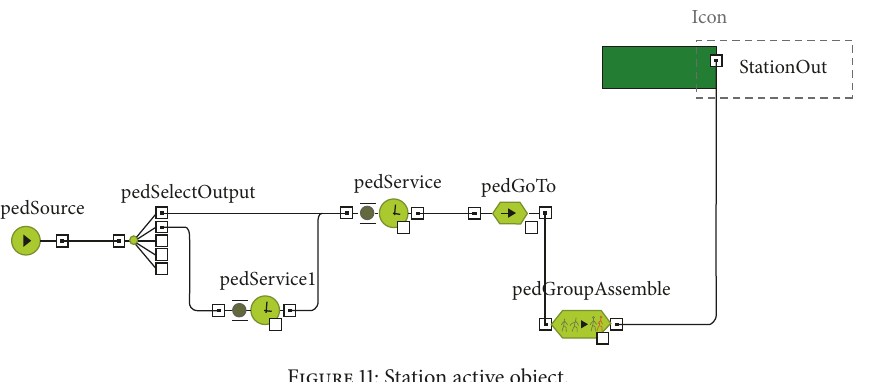
Figure 11: Station active